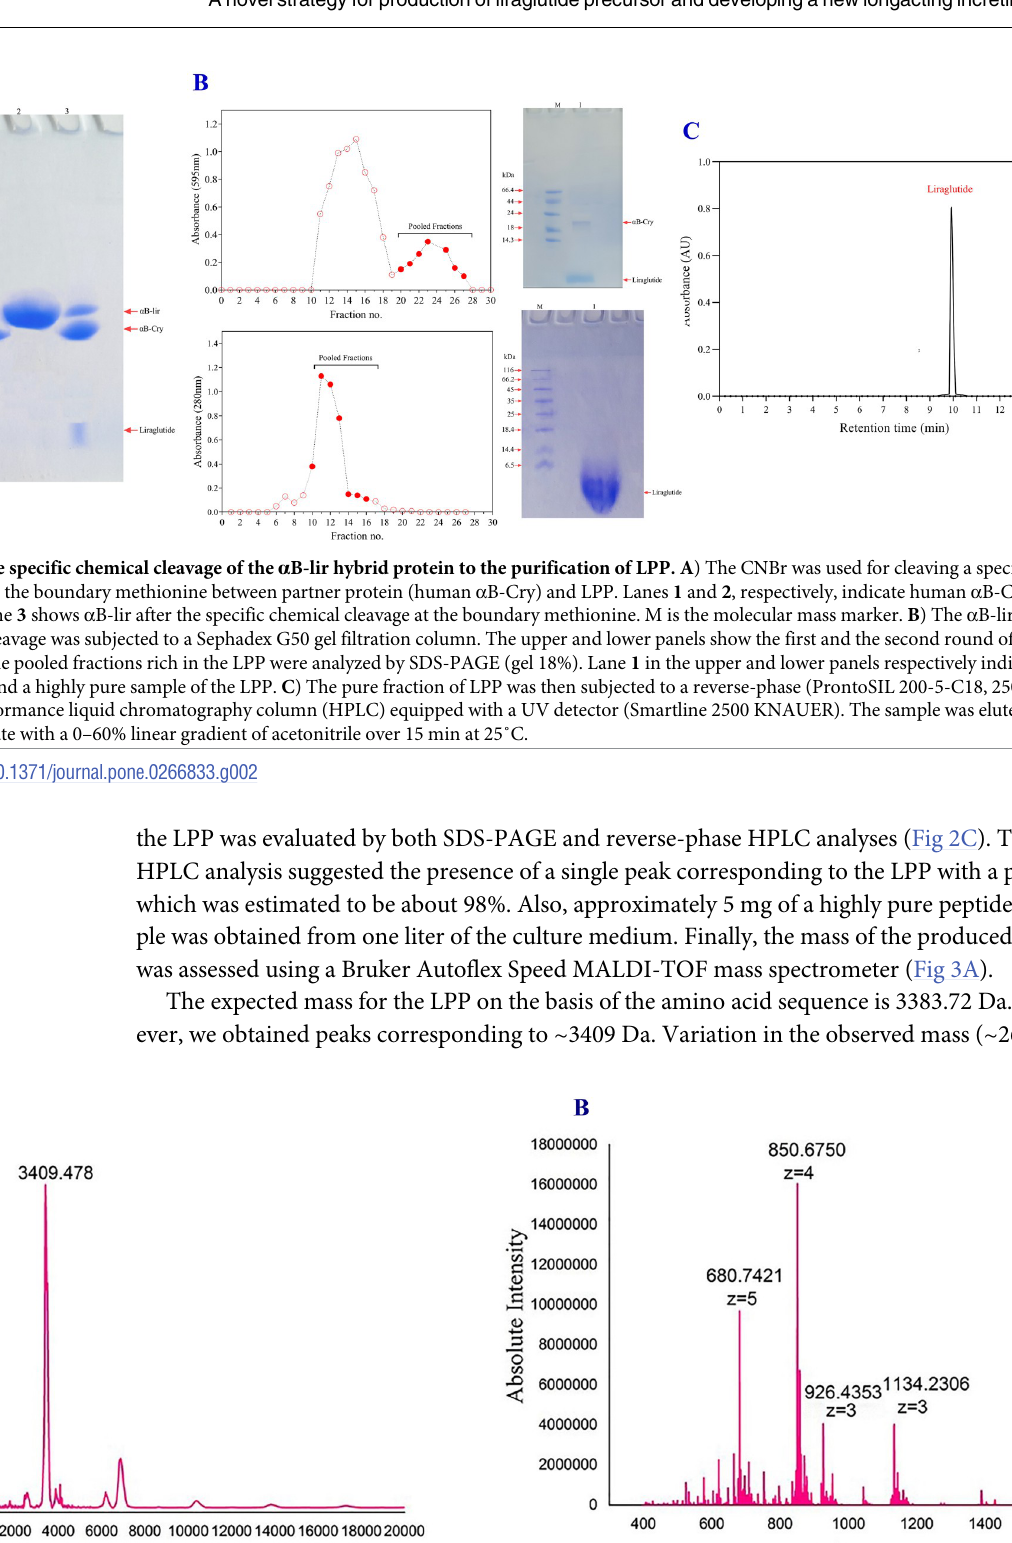
PLOS ONE | https://doi.org/10.1371/journal.pone.0266833 May 2,